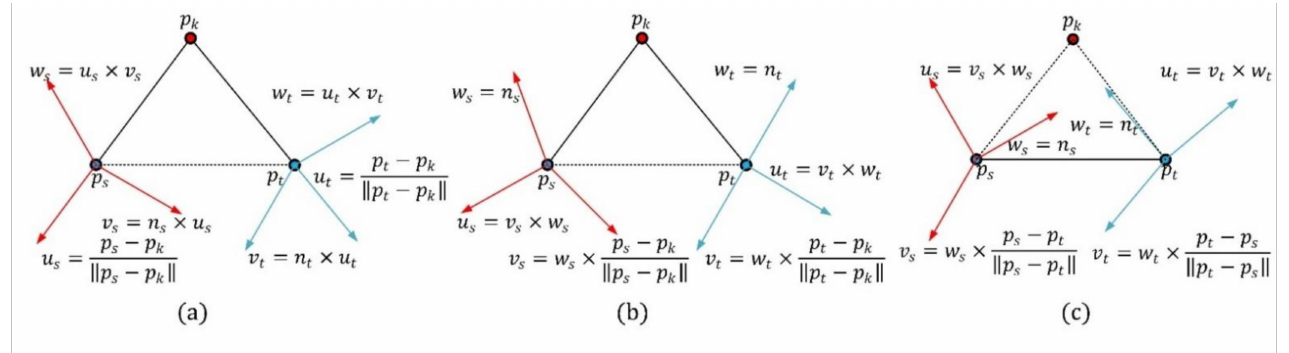
Figure 4. Different computing methods of the point-pair transformation matrix. ( a ) Proposed method. ( b ) Method-1 . ( c ) Method-2